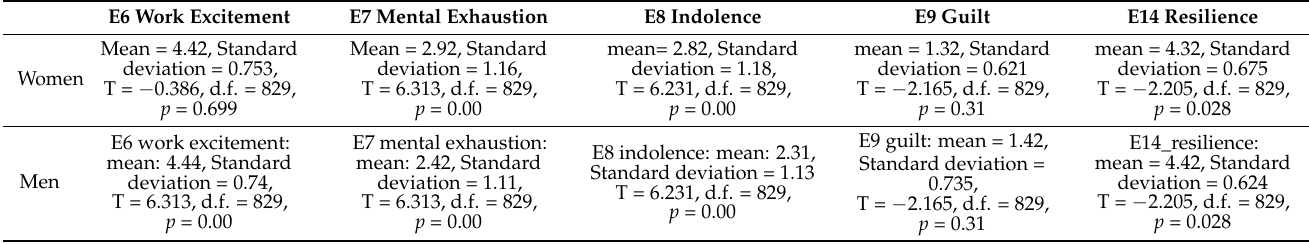
Table 3. Descriptive analysis: Differences between men and